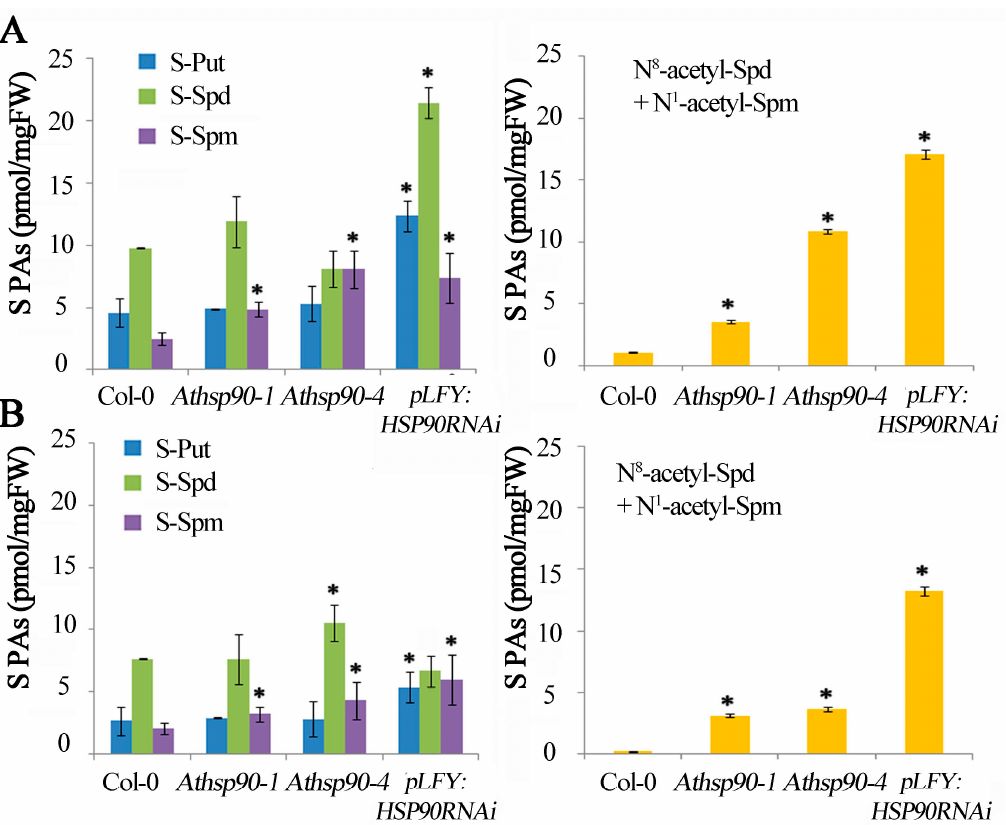
Figure 1. Endogenous polyamine titers in WT, Athsp90-1 , Athsp90-4 and pLFY:HSP90RNAi mutants of Arabidopsis thaliana . ( A ). Soluble Putrescine, Spermidine and Spermine (S-Put, S-Spd, S-Spm) and Soluble acetylated (N 8 -acetyl-Spd + N 1 -acetyl-Spm) polyamine contents in leaves of 15 day-old seedlings. ( B ). Soluble (S-Put, S-Spd, S-Spm) and soluble acetylated (N 8 -acetyl-Spd + N 1 -acetyl-Spm)